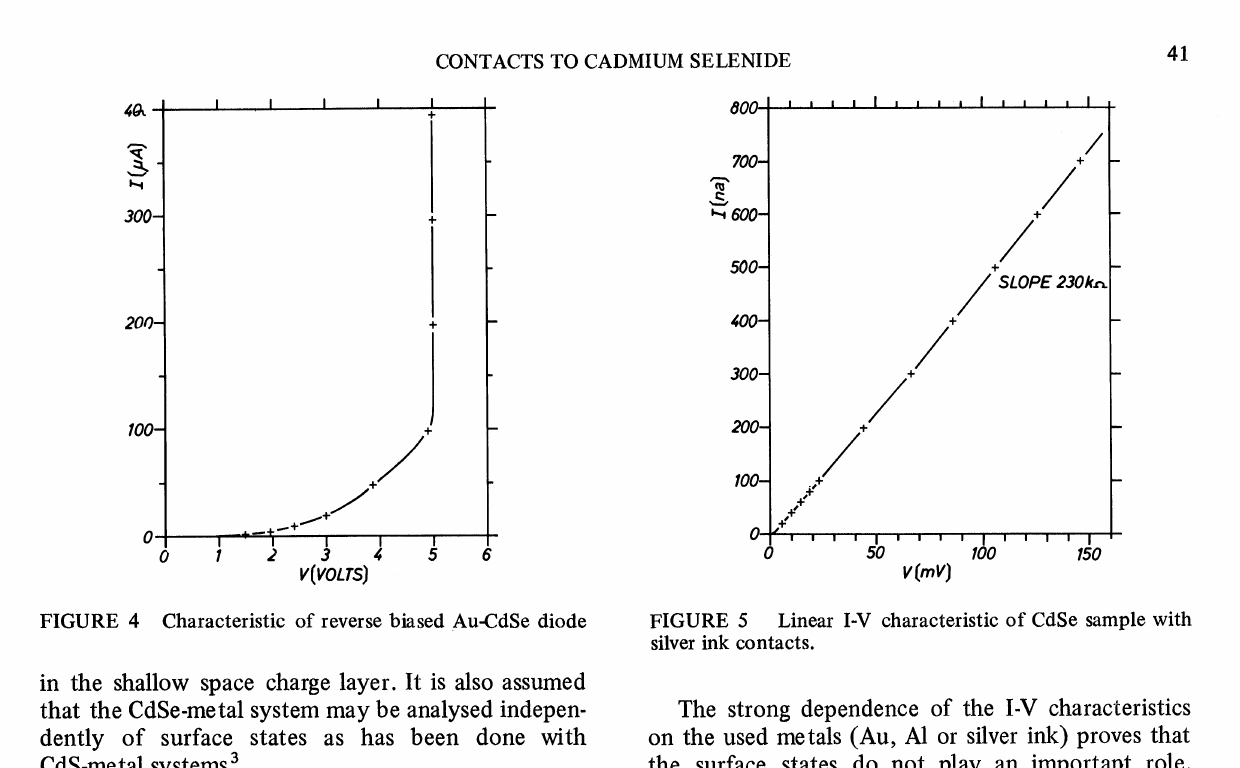
FIGURE 4 Characteristic of reverse biased Au-CdSe diode FIGURE 5 Linear I-V characteristic of CdSe sample with silver ink